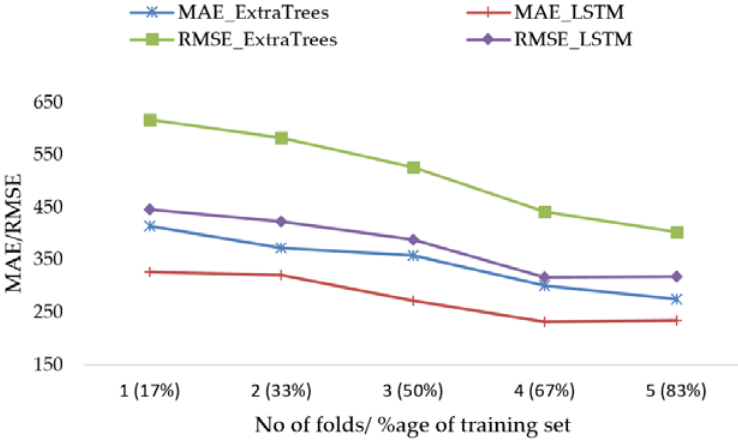
Figure 14 . Time series cross validation with Multiple Train ‐ Test Splits.